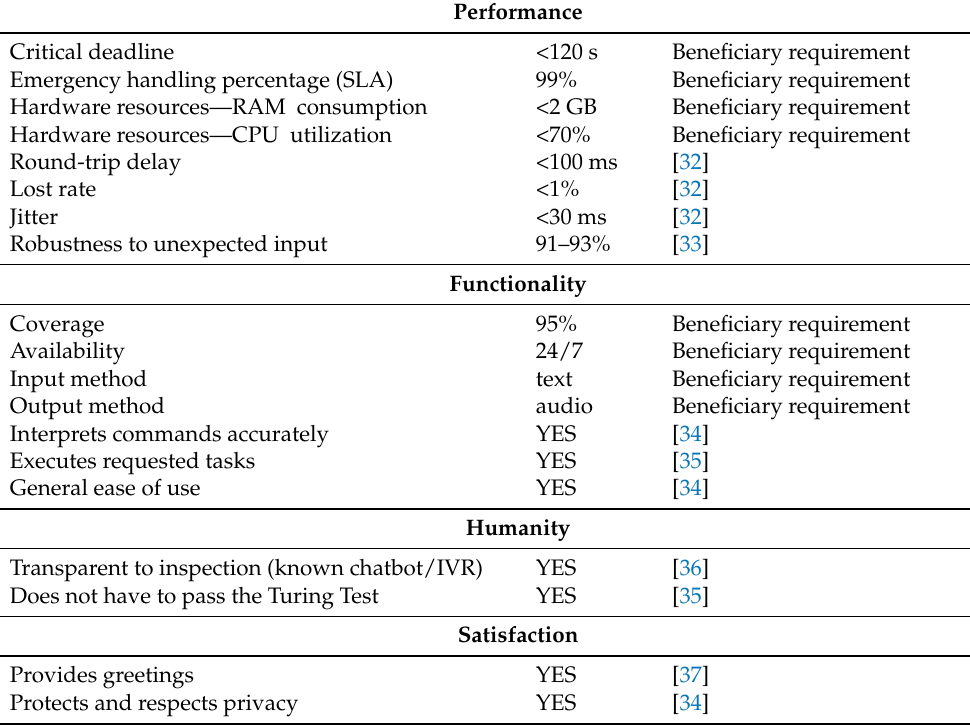
Table 1. Requirements and specifications of the chatbot/IVR